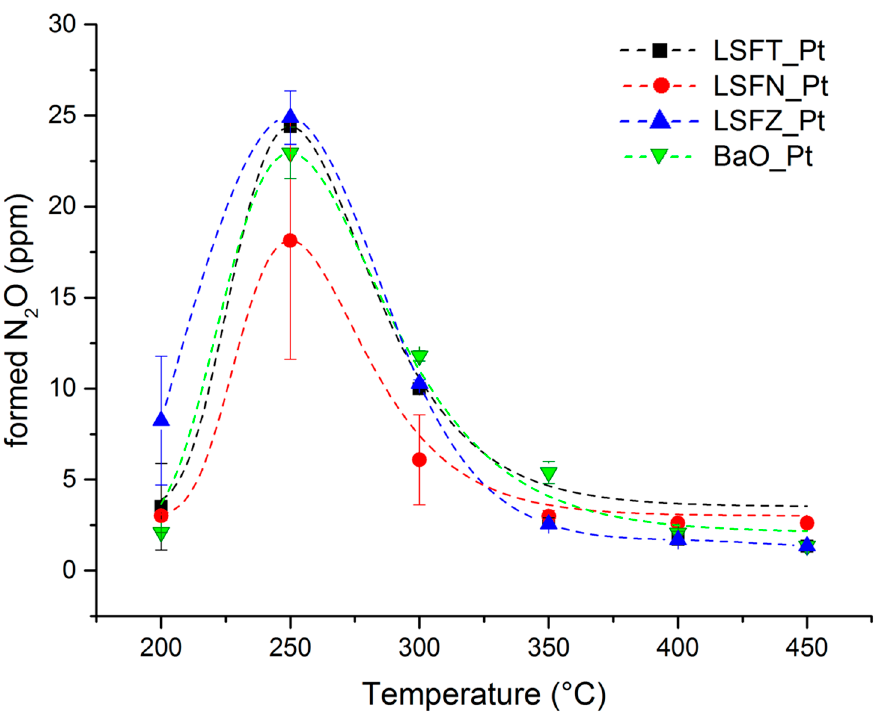
Figure 1. Temperature dependence of N 2 O formation during the adsorption phase at lean operation conditions for different Pt-coated perovskite-based LNT catalysts. Data for the reference catalyst 2.5 wt. % Pt/20 wt. % BaO/Al 2 O 3 (BaO_Pt) are given for comparison.